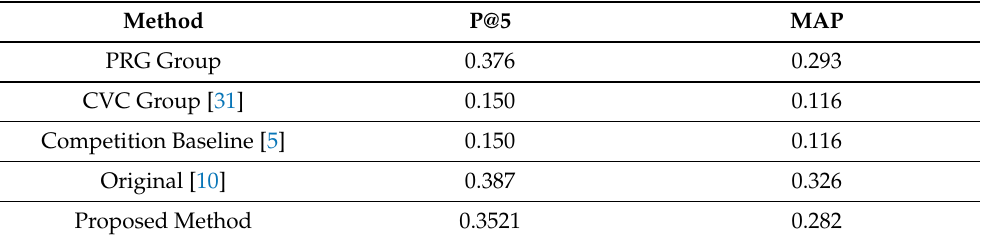
Table 4. Experimental results for Track I.B.—training and segmentation-free (ICDAR15